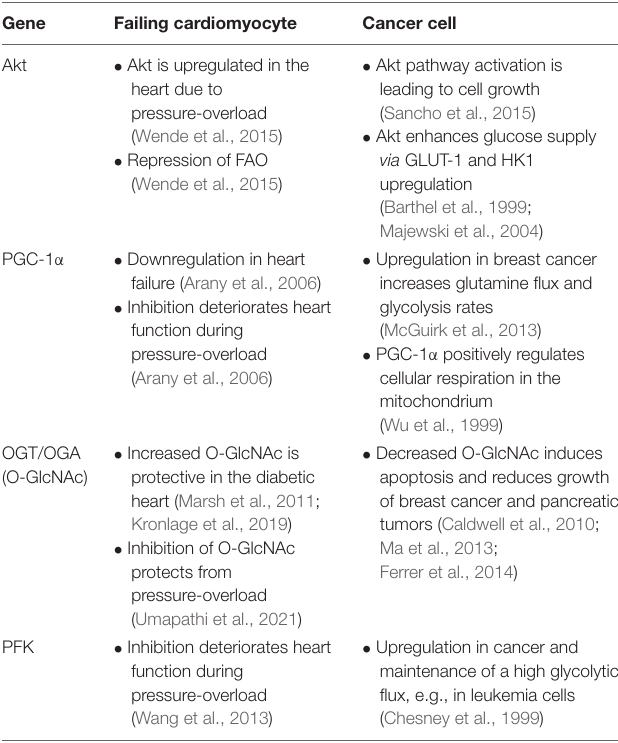
TABLE 2 | Regulation of metabolic genes in failing cardiomyocytes and cancer cells. Gene Failing